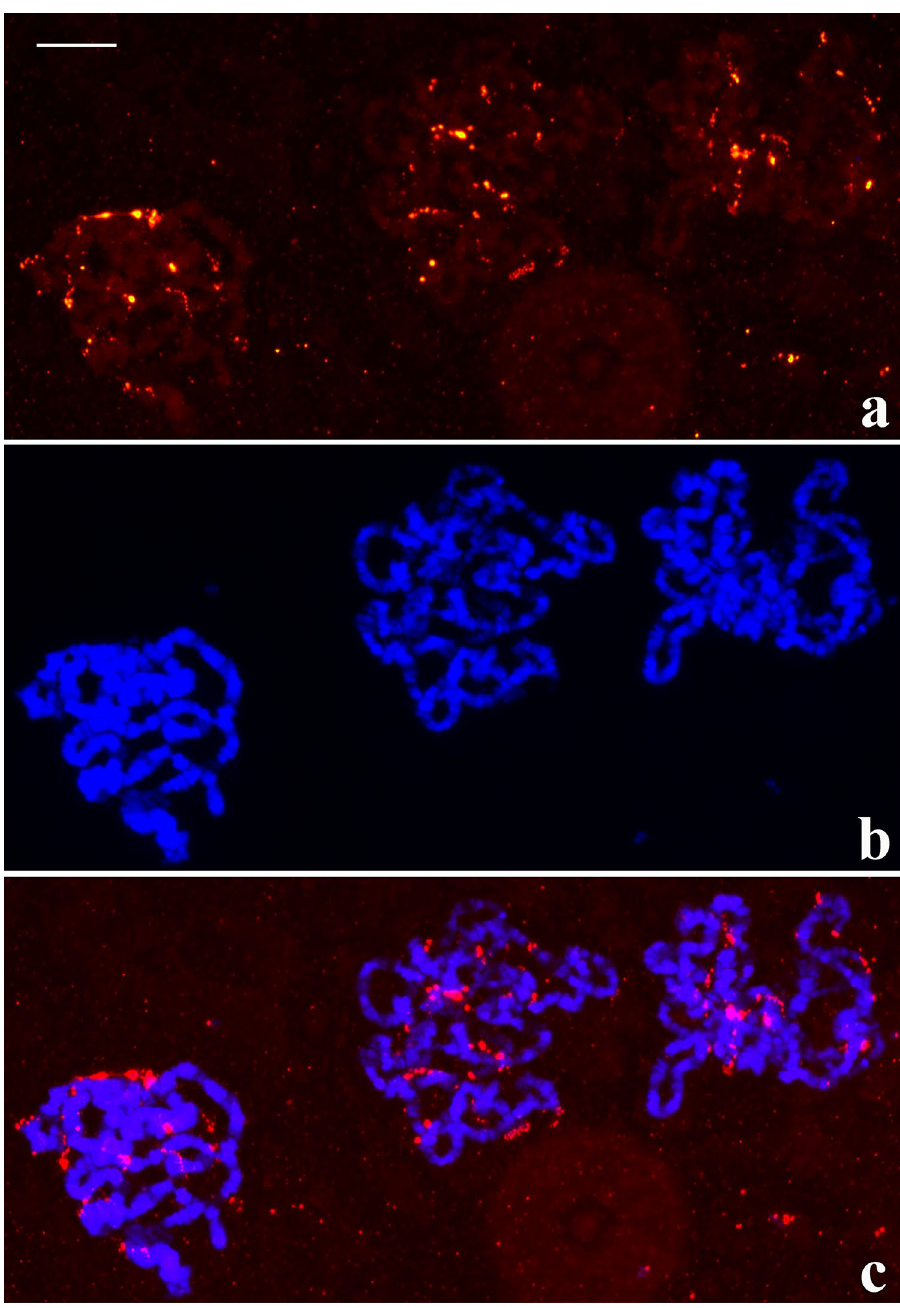
Figure 3. ( a–c ) Localisation of the rDNA in Schwenkfeldina sp. polytene chromosomes from posterior cells of the salivary gland showing rDNA dispersion at a lesser extent than nuclei from anterior cells as inferred by RNA probe signals ( a ), its corresponding DAPI staining image ( b ) and the merged signals ( c ). Bar = 65